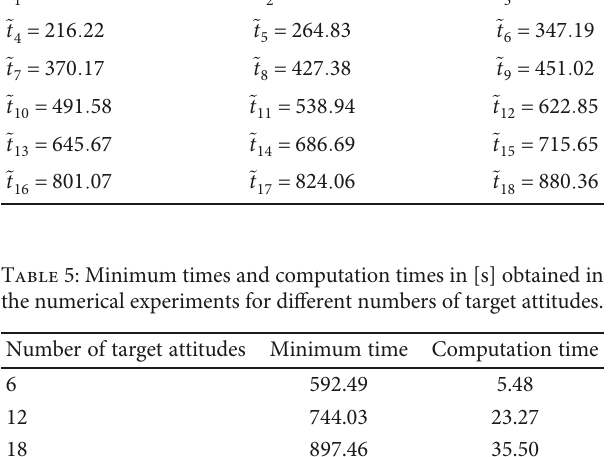
Table 4: Switching times expressed in [s] of the optimal solution of experiment C with 18 target attitudes.